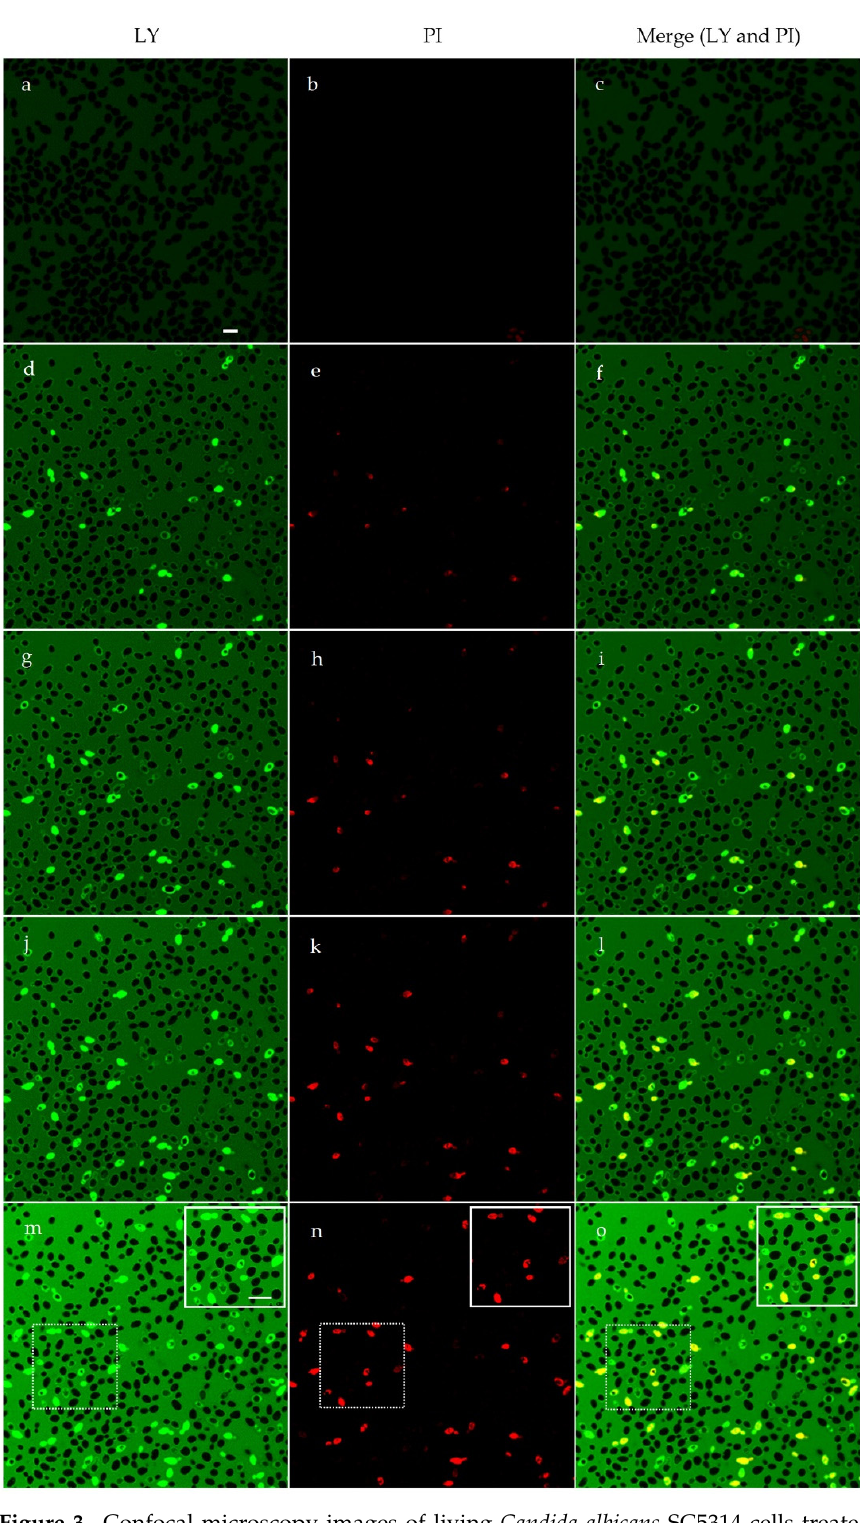
Figure 3. Confocal microscopy images of living Candida albicans SC5314 cells treated with Ma1. ( a – c ) Yeast cells, pre-treated with propidium iodide (PI) and lucifer yellow (LY), were treated with Ma1. Images were taken after ( d – f ) 10 min, ( g – i ) 20 min, ( j – l ) 30 min, and ( m – o ) 60 min. The same field is shown. Over time, LY is increasingly evidenced inside yeast cells, with subsequent internalization of PI, suggesting an irreversible membrane permeabilization induced by the peptide, eventually resulting in cell death. Prior to internalization, LY is localized at the cell wall level. The inset in panels ( m – o ) shows a detail of the field highlighted by dotting. Bar, 10 µm.